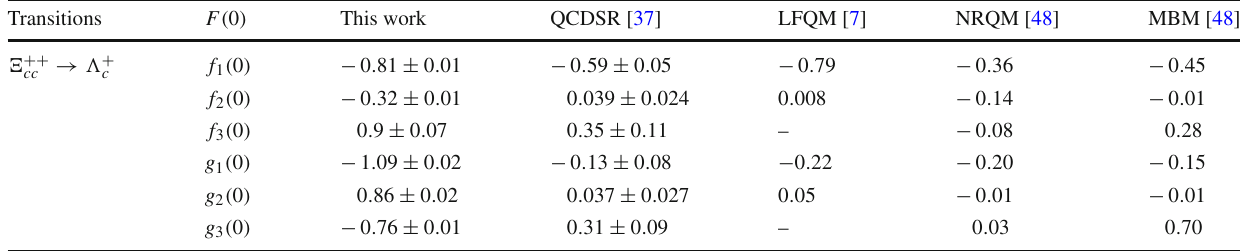
Table 4 Comparison of our results of (cid:3) cc decay form factors with the results from QCD sum rules (QCDSR) [37], light-front quark model (LFQM) [7], the nonrelativistic quark model (NRQM) and the MIT bag model (MBM) [48] Transitions F ( 0 ) This work QCDSR [37] LFQM [7] NRQM [48] MBM [48]